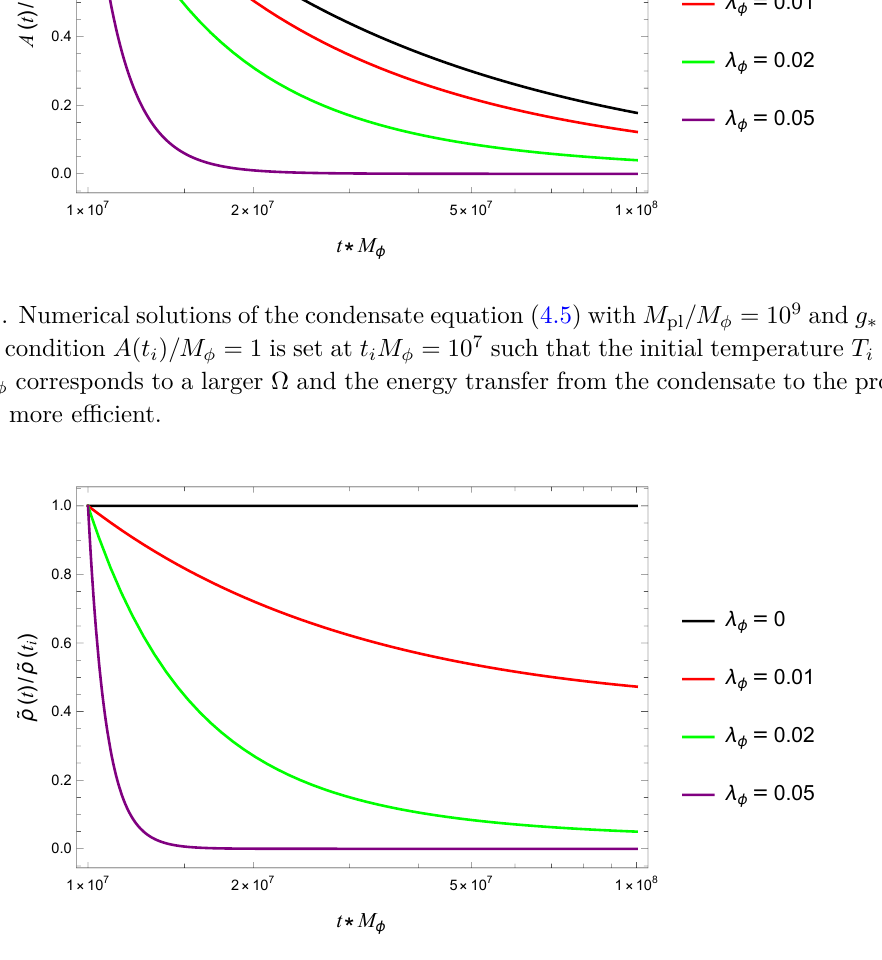
Figure 13 . Evolution of the condensate comoving energy density for the numerical solutions given in figure